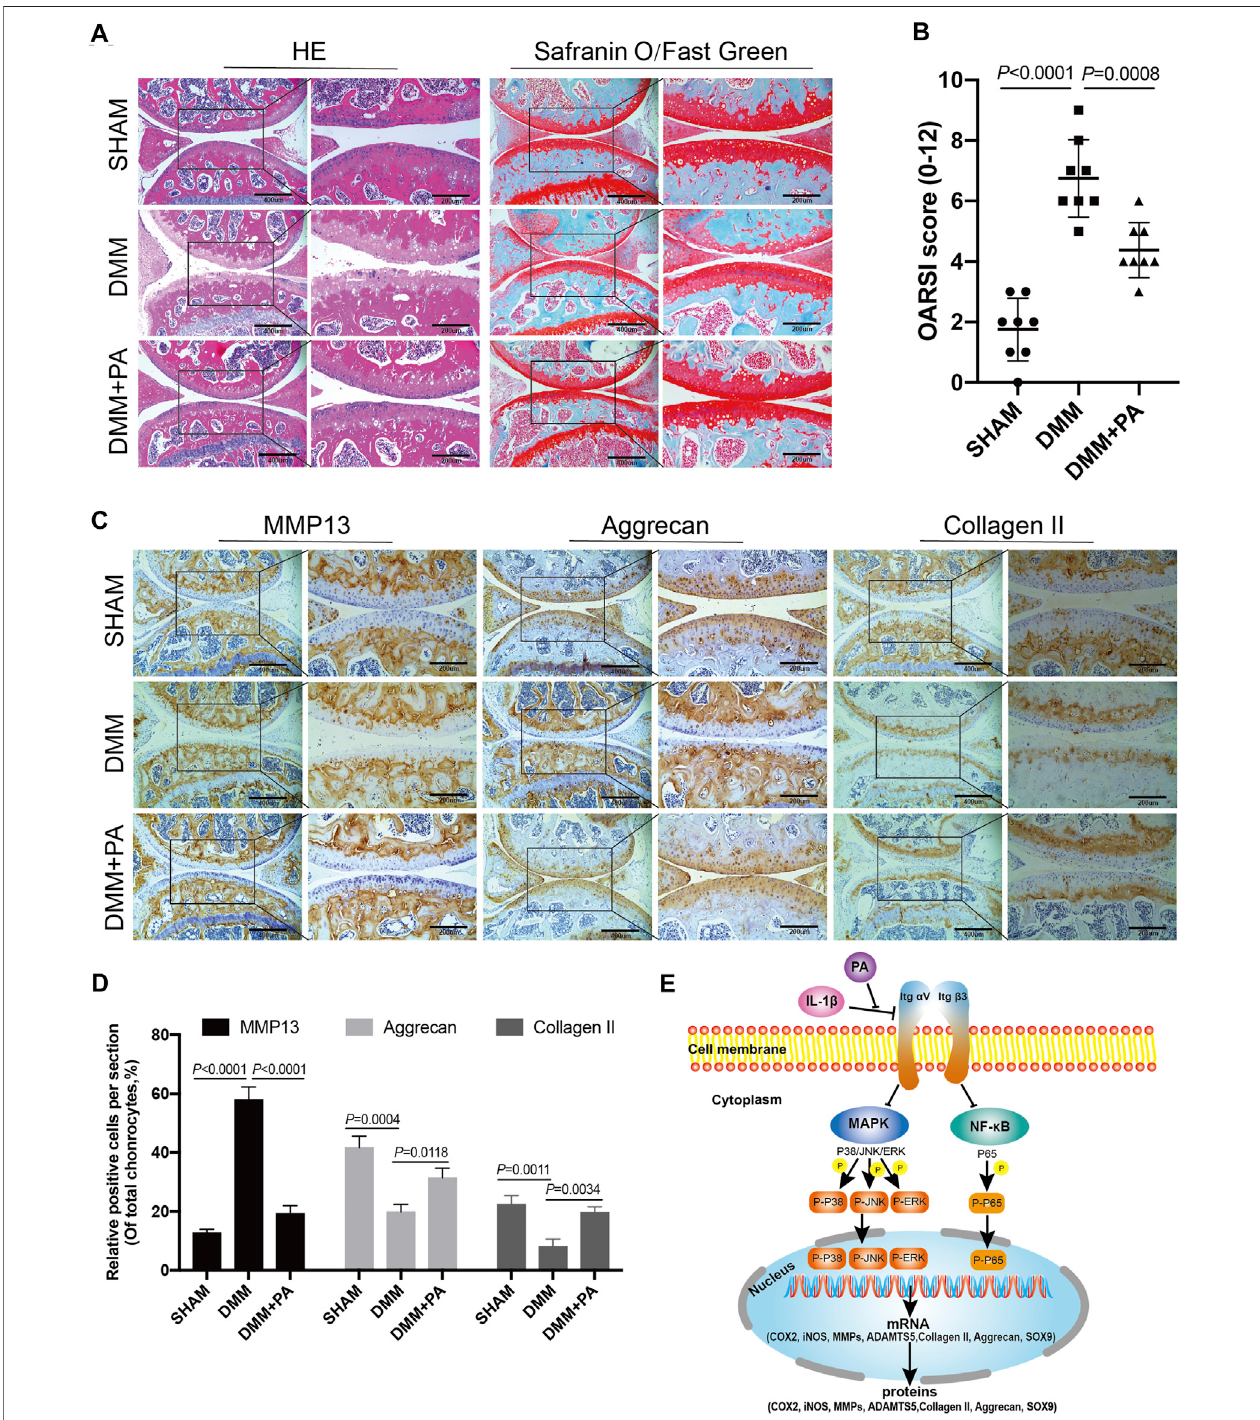
FIGURE 8 | PA attenuated cartilage destruction in the in vivo mouse OA model. (A) HE, Safranin O, and Fast Green staining and (B) OARSI scores of mice knee jointsfromthesham,DMM,andDMM +PAgroupsat 8 weeksafterthecorrespondingtreatment (scalebars,200and400 μ m). (C) Immunohistochemistrystainingand (D) quanti fi cation of the expression of MMP13, aggrecan, collagen II were measured among the three groups (scale bars 200 and 400 μ m). Data are presented as means ± SD ( n (cid:1) 6). The exact p value was marked in the corresponding fi gure and p < 0.05 was considered statistically signi fi cant. (E) The potential molecular mechanism of PA ’ s chondroprotective effect. PA could alleviate the in fl ammatory response and cartilage degradation of IL-1 β -induced chondrocytes by inhibting the MAPK and NF- κ B signaling pathways, and the bene fi cial effect of PA on OA may be mediated through integrin α V β 3.